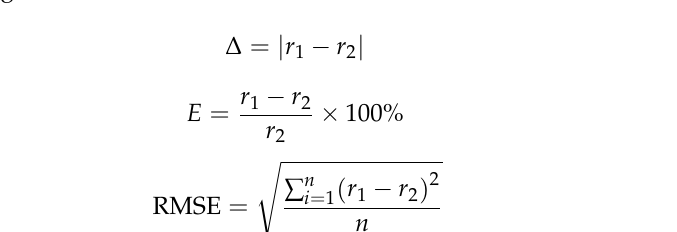
Figure 3. Structure of the tree and measurement position. Two stations were placed in front of the forest, one in the forest and eleven behind the forest. The stations were placed at equal intervals from 1 H onwards in the post-forest.